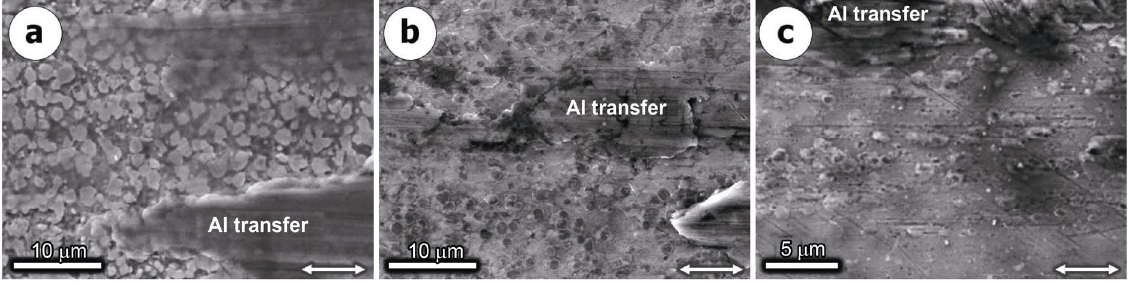
Fig. 15 SEM micrographs of the worn mirror-polished (a) tool steel A (using 15 kV), (b) tool steel V (15 kV), and (c) tool steel O (10 kV) pin samples at 5,000× magnification, showing the initiation of aluminium transfer from the protruding carbides ( ↔ indicates the sliding